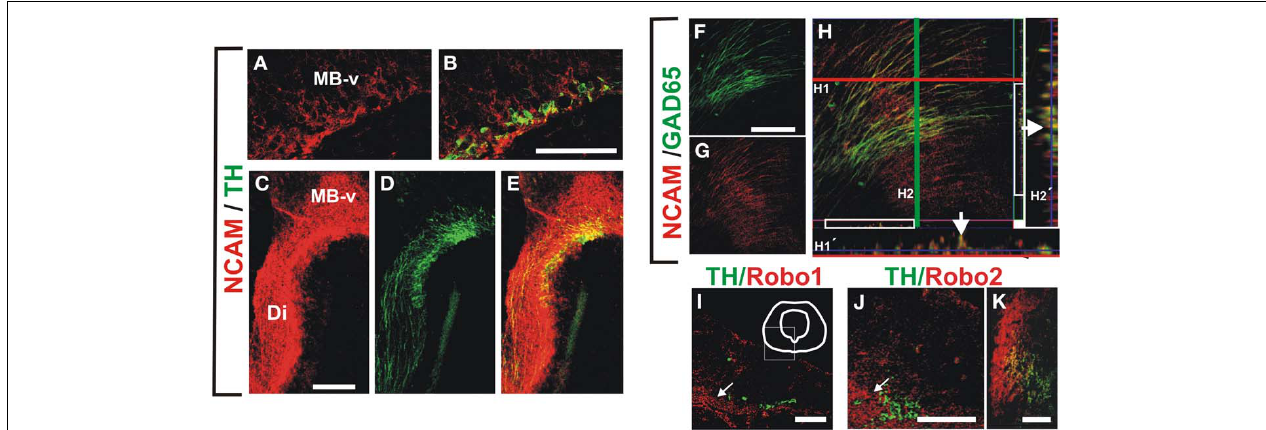
FIGURE 5 | NCAM is expressed in midbrain dopaminergic and descending GAD65 neurons and non-dopaminergic longitudinal axon bundle expresses Robo proteins. Whole rat brains or frozen sections were immunostained for NCAM (red) and either TH or GAD65 (both in green). (A,B) Show sagittal sections of the ventral midbrain (MB-v) of an E12 embryo. (C–E) Are images of a frame in the diencephalon of an E13 embryo. (F–H) Are images of a sagittal section in the ventral midbrain